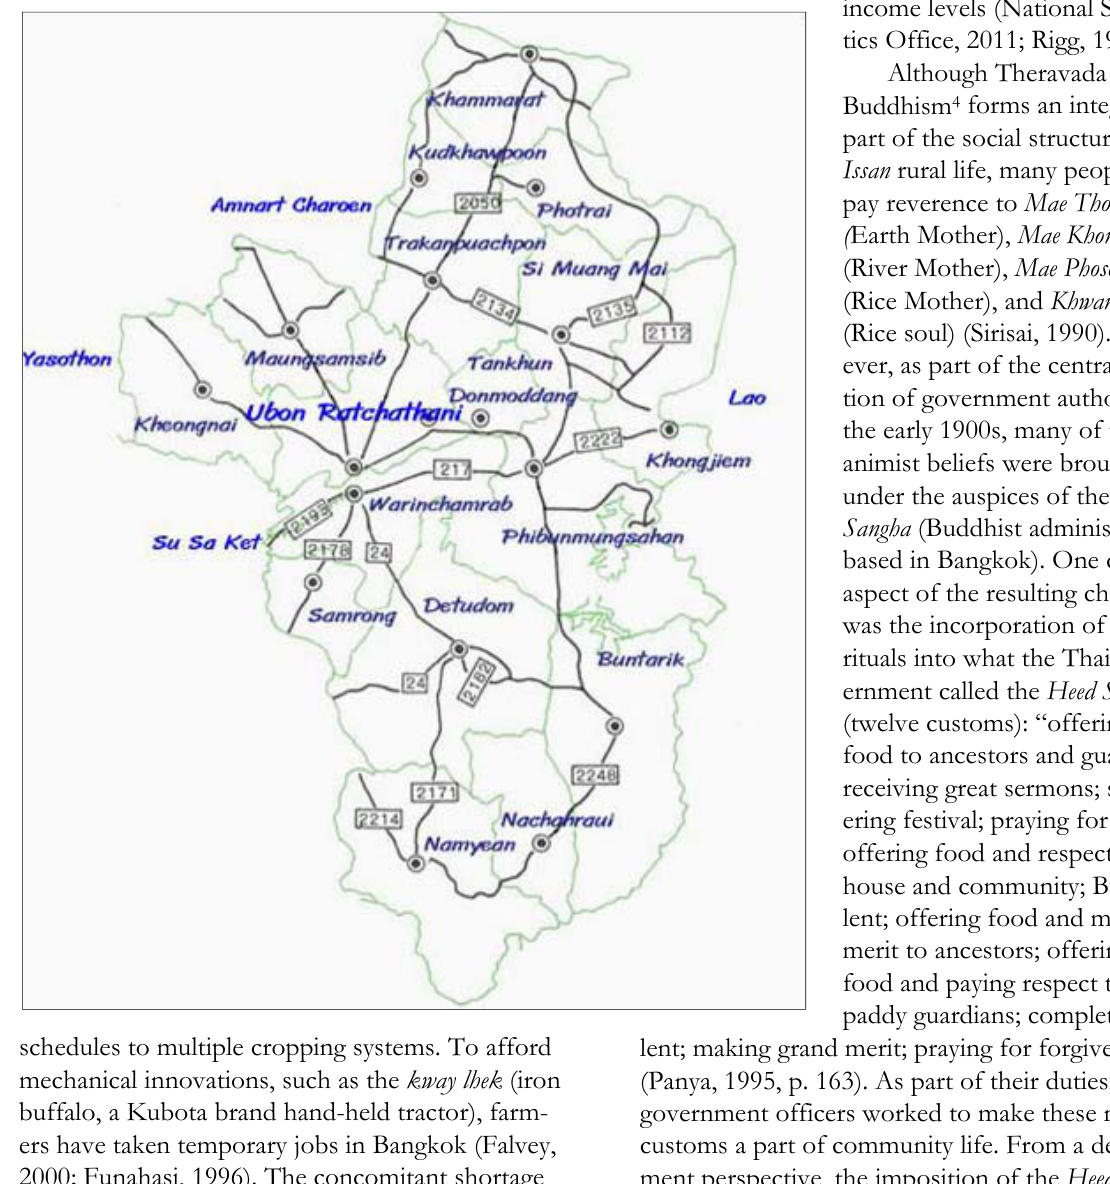
Figure 1. Ubon Ratchathani, Northeast Region of